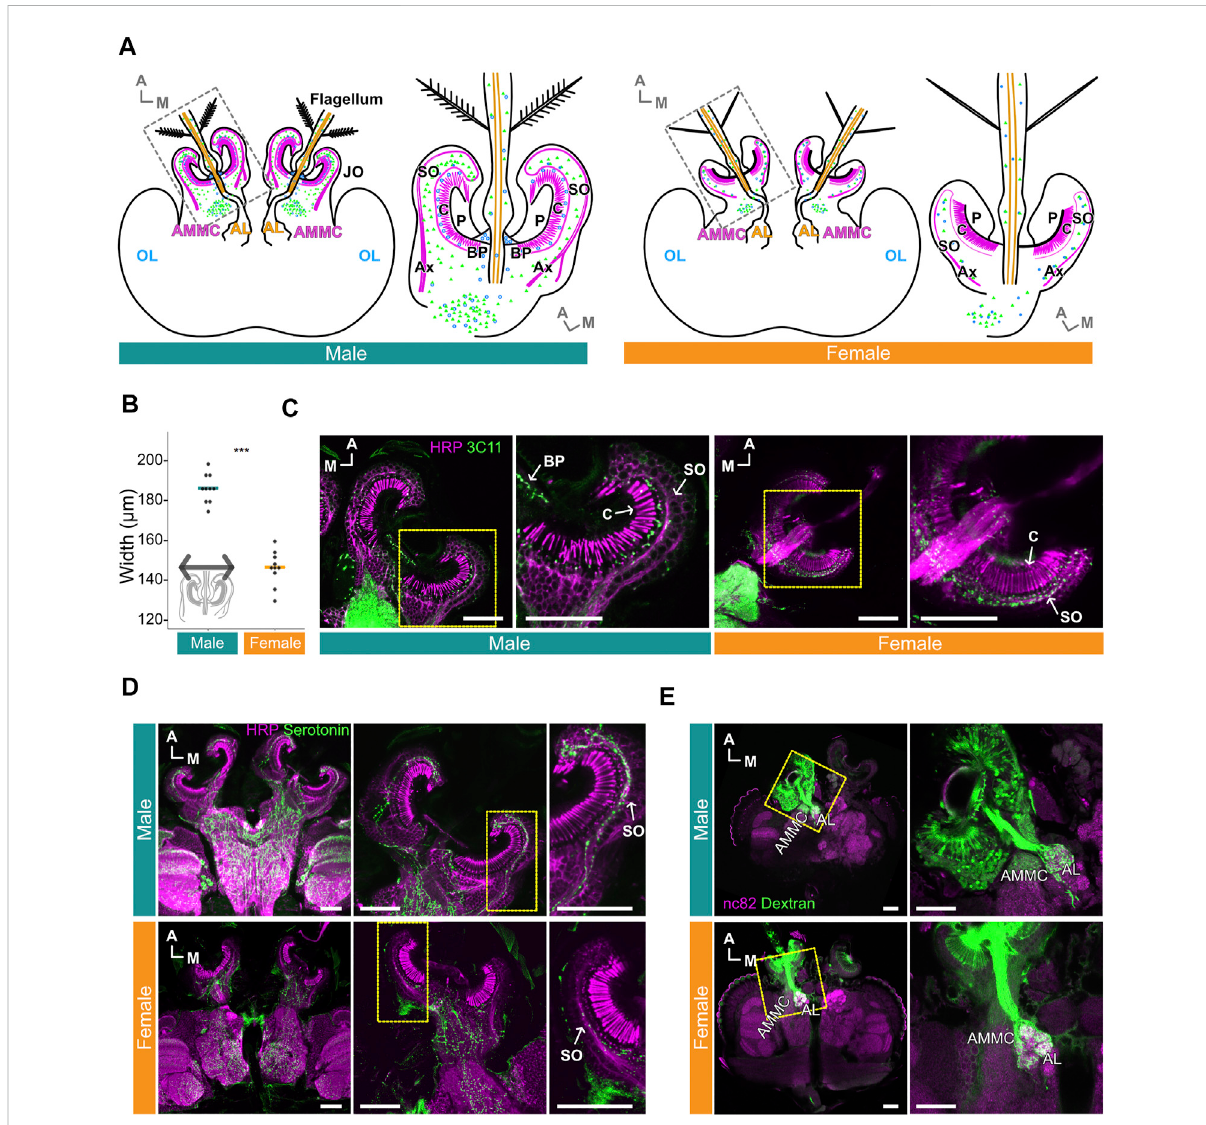
FIGURE 1 Serotoninisdistributedthroughoutmaleandfemale Ae.aegypti fl agellar ears. (A) Schematicdiagramsofmale(left)andfemale(right)brainsand ears (JO and fl agellum). Magenta and orange represent JO neurons and fl agellar neurons in the ear, respectively. Green and blue dots represent serotonin and presynaptic sites, respectively. AL, Antennal lobe; AMMC, Antennal mechanosensory and motor center; Ax, axons of JO neurons; BP, basalplate;C,ciliaofJOneurons;OL,opticlobe;P,prong;SO,somataarrayofJOneurons. (B) DiametersofmaleandfemaleJOs(in μ m).Dots represent individual diameter values, solid bars represent medians for each group. Inset, representation of length used to de fi ne diameter. (C) Presynaptic sites in JOs. Sections of male (left) and female (right) JOs are shown anti-horseradish peroxidase (HRP) staining (magenta) allows for visualizing neurons, anti-SYNORF1 (3C11) staining (green) labels presynaptic sites. Yellow frames indicate the positions for the right panels. (D) Serotoninsignal inmale and female brains and JOs. HRP staining (magenta)allows for visualizing neurons, serotonin staining (green) shows location of serotonin. Yellow frames in the middle panels indicate the positions for the right panels. (E) Projection patterns of JO and fl agellar neurons from the ear to the brain in male (top) and female (bottom) as visualized by anterograde Dextran staining. anti-bruchpilot (nc82) staining (magenta)allows forvisualizingneurons,Dextrandyestaining(green)tracesJOand fl agellarneuronsfromtheeartothebrain.Yellowframesindicatethepositionsfor the right panels. (A – E) A, anterior; M, medial. Horizontal views of the brain and JO. (C – E) Scale bar = 50 μ